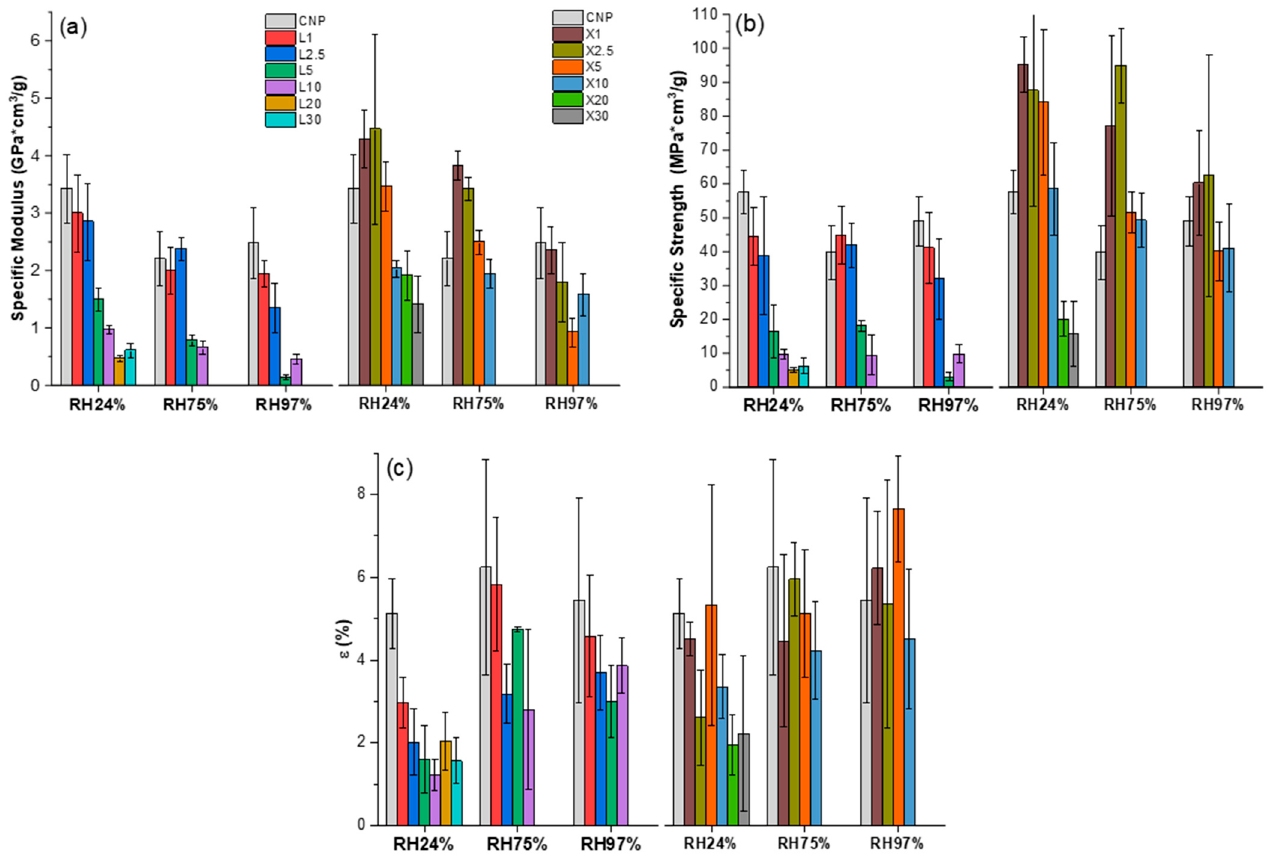
Figure 10. Tensile properties: ( a ) specific elastic modulus, ( b ) specific ultimate tensile strength, and ( c ) elongation at break for NPs saturated under different RH.